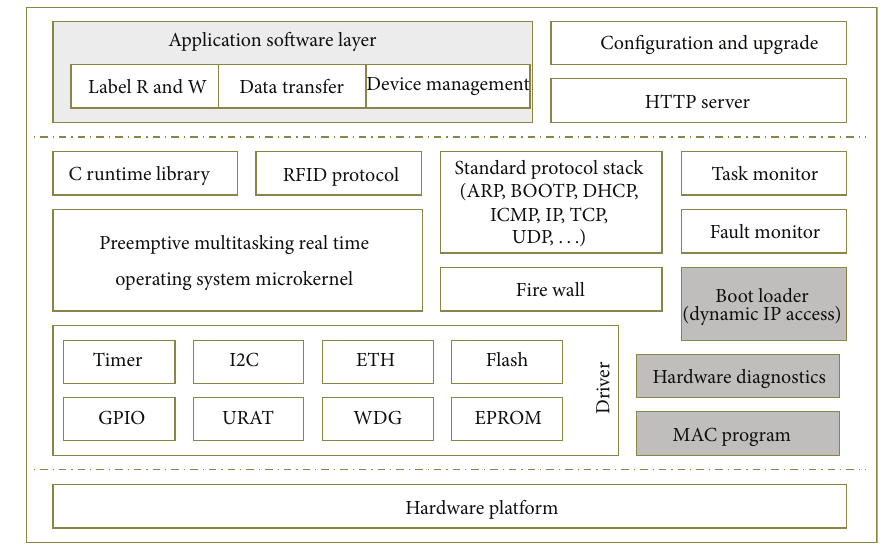
Figure 6: Front-end software infrastructure of RFID